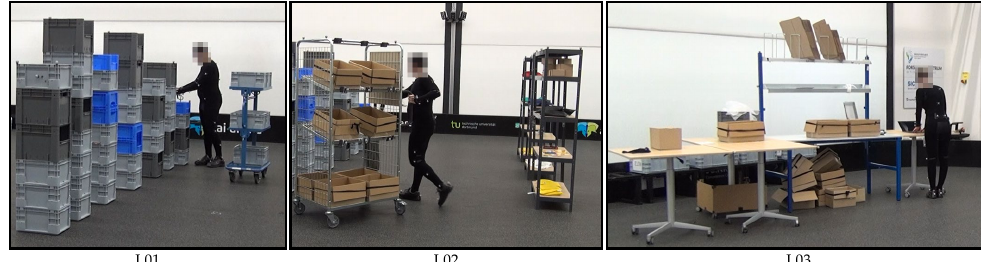
Figure 2. Extracts from the physical laboratory set-up of all three logistics